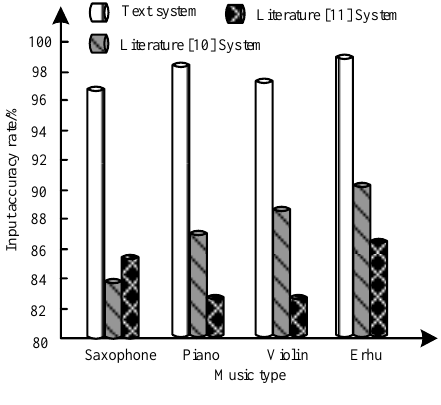
Figure 7. The correct rate of music